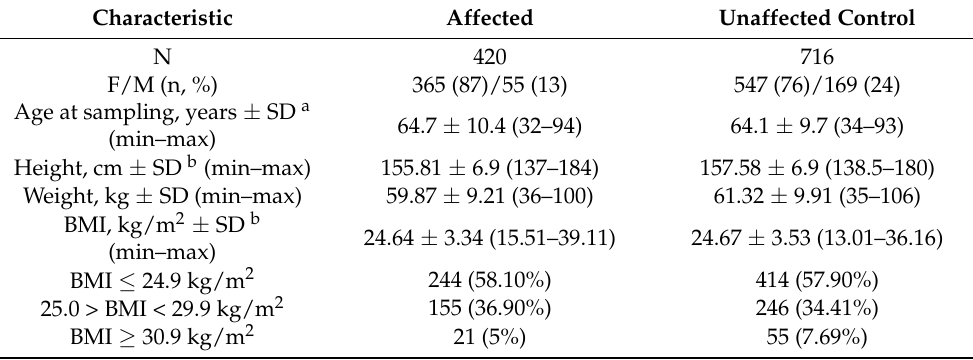
Table 1. Basic characteristics of study populations.